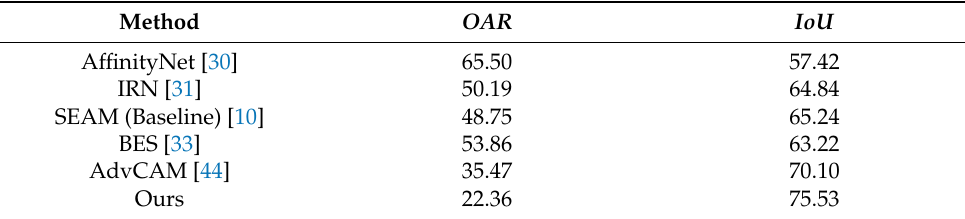
Table 3. Comparison with state-of-the-art methods for handling the over-activation problem. OAR (%; the lower the better). IoU (%; the higher the better).